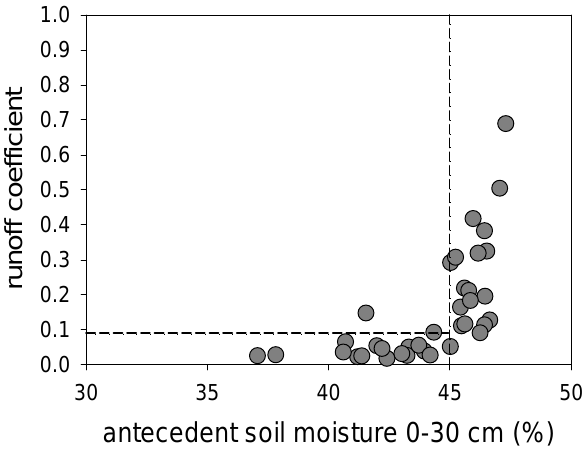
Figure 4. Threshold behaviour in the relationship between average soil moisture at 0-30 cm prior 660 Fig. 4. Threshold behaviour in the relationship between average to the event and the runoff coefficient. The vertical line highlights the soil moisture threshold, the 661 soil moisture at 0–30cm prior to the event and the runoff coeffi- horizontal line represents the value of runoff coefficient corresponding to the ratio between the 662 cient. The vertical line highlights the soil moisture threshold, the riparian area and total catchment area. 663 horizontal line represents the value of the runoff coefficient corre- sponding to the ratio between the riparian area and total catchment